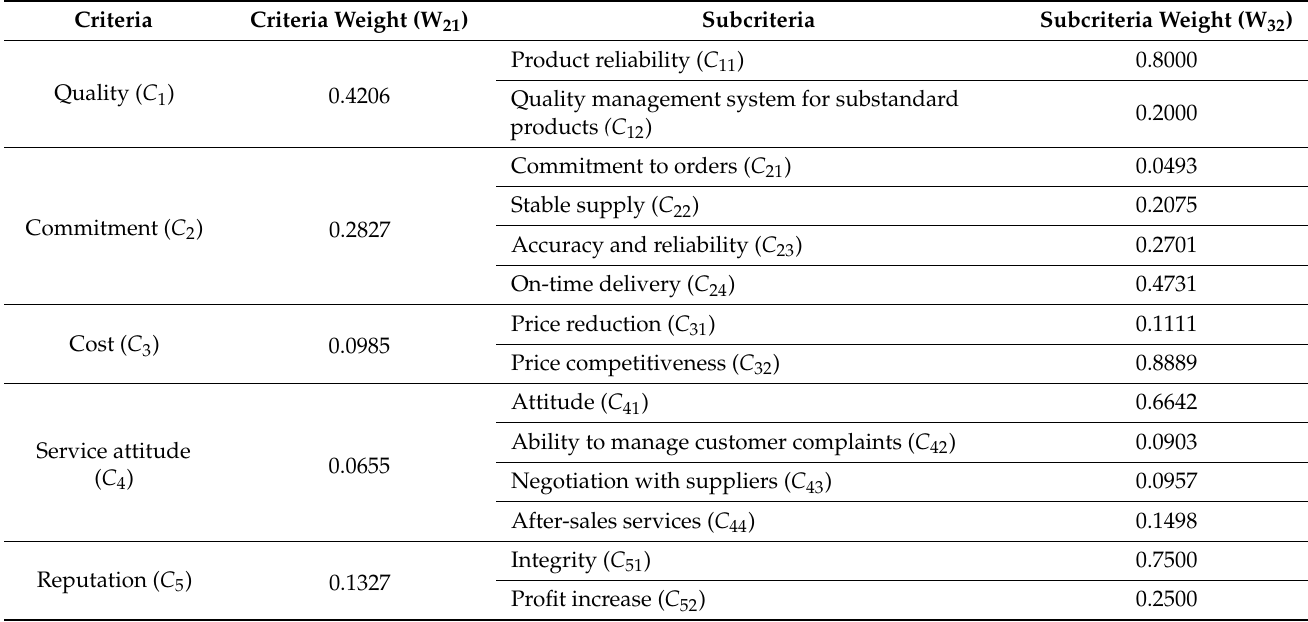
Table 7. Weights for criteria and